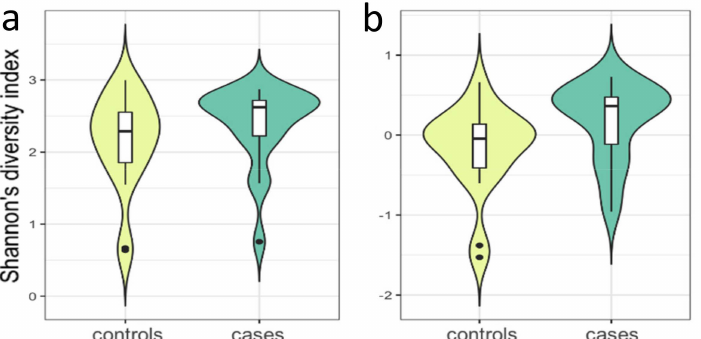
Figure 3. Violin plots showing the distribution of the Shannon diversity index, ( a ) Unadjusted, b: Adjusted for stool consistency, day of menstrual cycle at sample collection and sequencing read depth. The negative values in ( b ) are due to the fact that residuals after adjustment were used in the plots, for a more precise